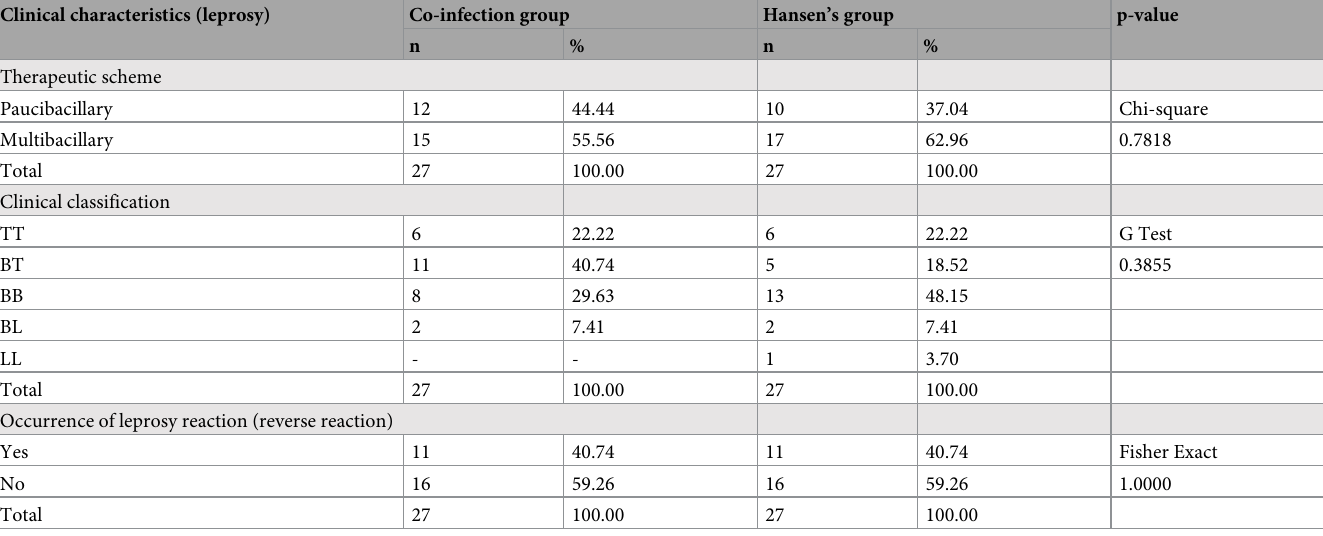
Table 2. Clinical characteristics related to leprosy in patients with and without HIV co-infection treated at a referral center, Bele´m—Para´, from 2003 to 2017. Clinical characteristics (leprosy)